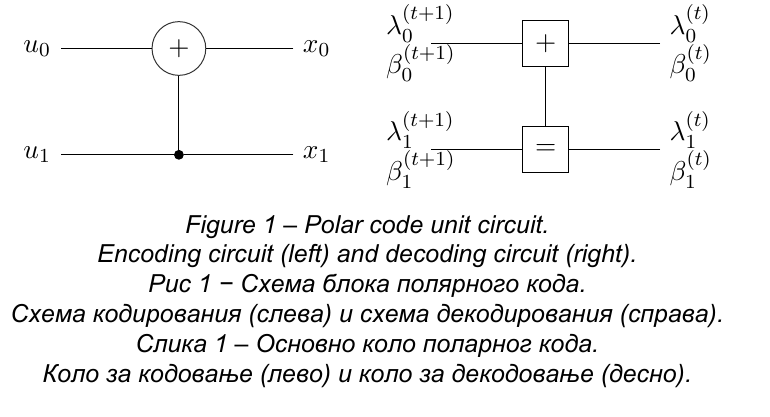
Figure 1 – Polar code unit circuit. Encoding circuit (left) and decoding circuit